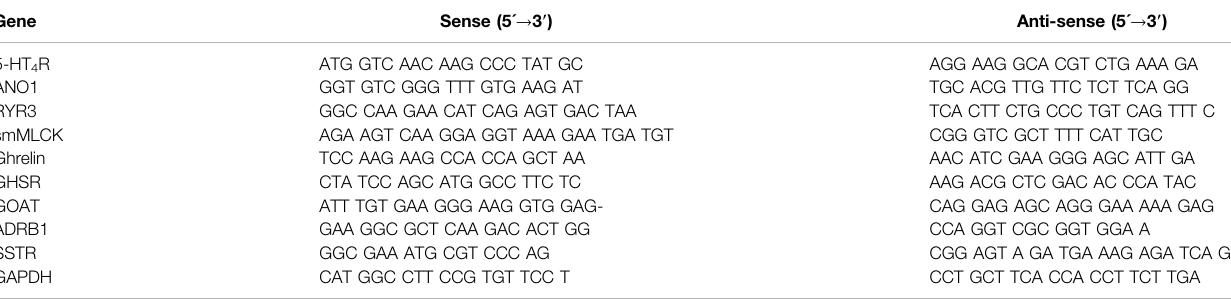
TABLE 2 | Summary for gene